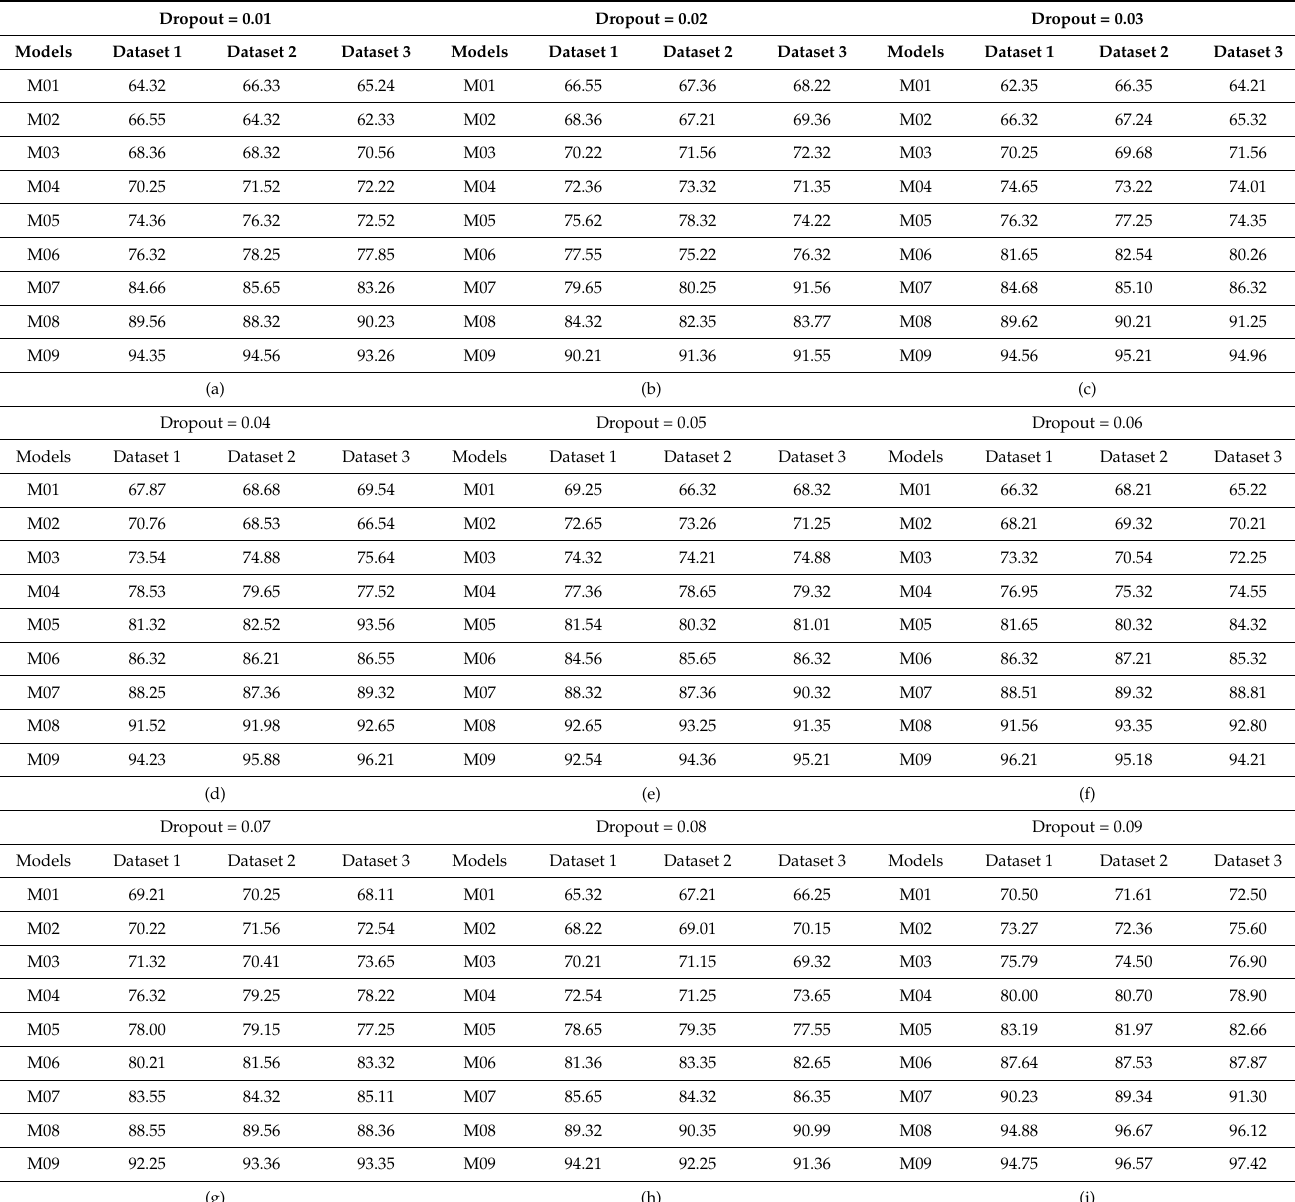
Table 7. The performance accuracy (%) for an embedding size of